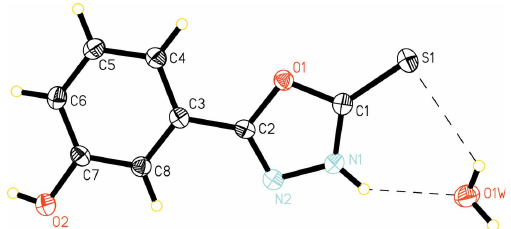
Figure 1 Structures of the molecular entities of the title compound. Displacement ellipsoids are drawn at the 30% probability level; hydrogen bonds are indicated by dashed